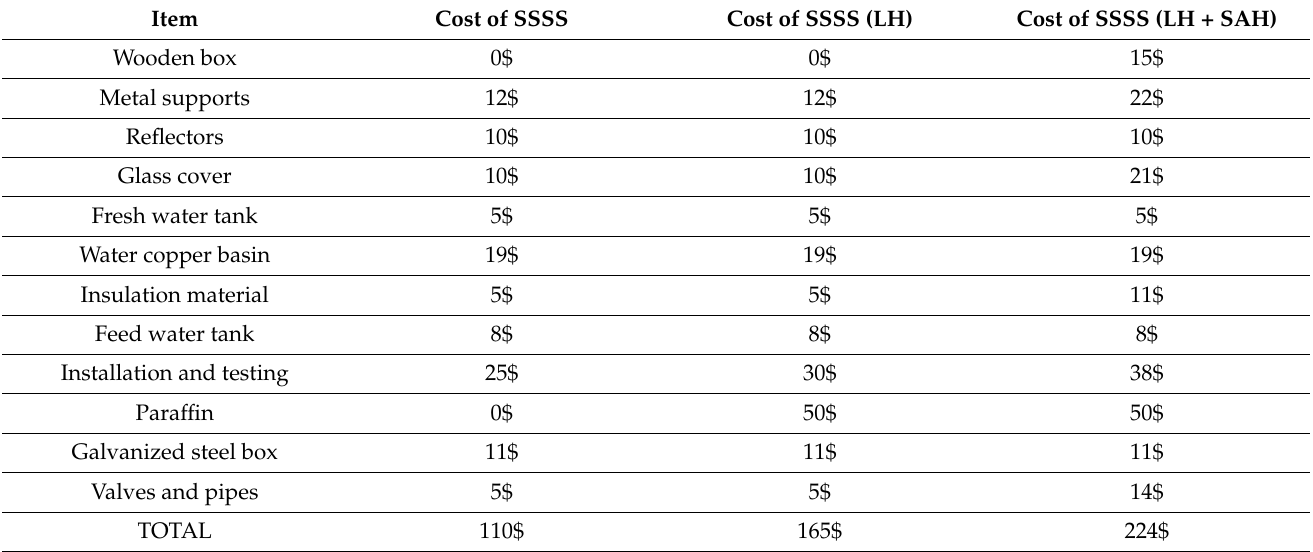
Table 8. Cost of Latent heat storage-based